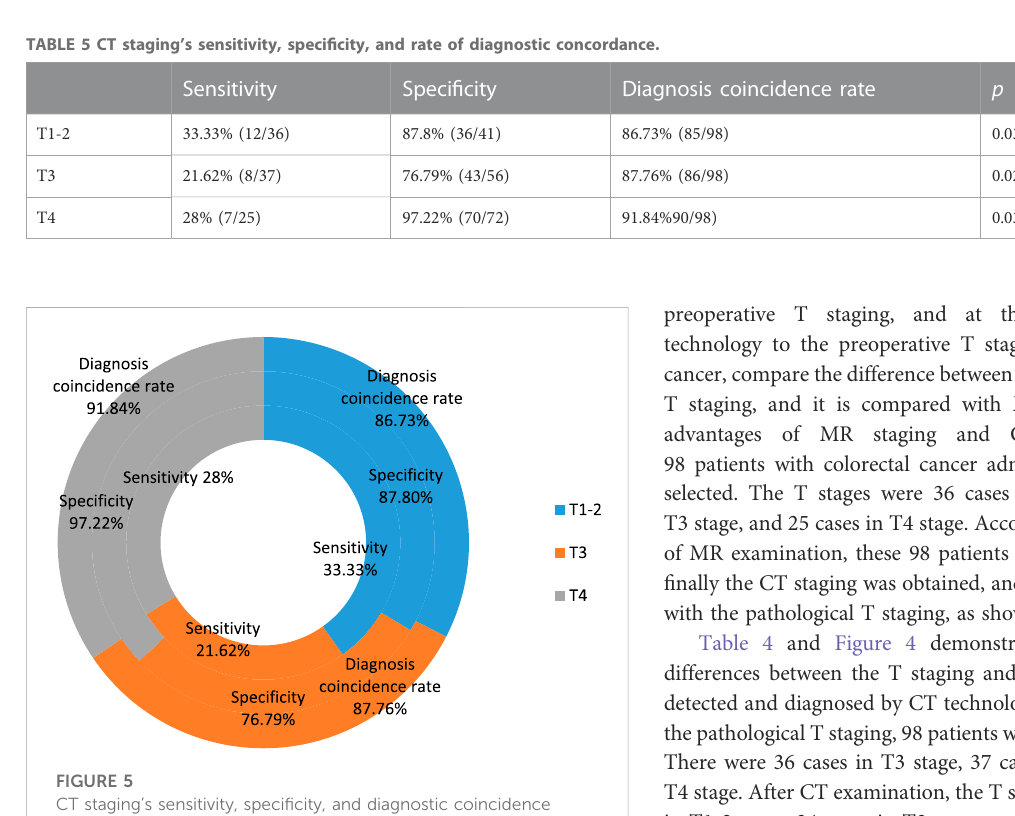
FIGURE 5 CT staging ’ s sensitivity, speci fi city, and diagnostic coincidence